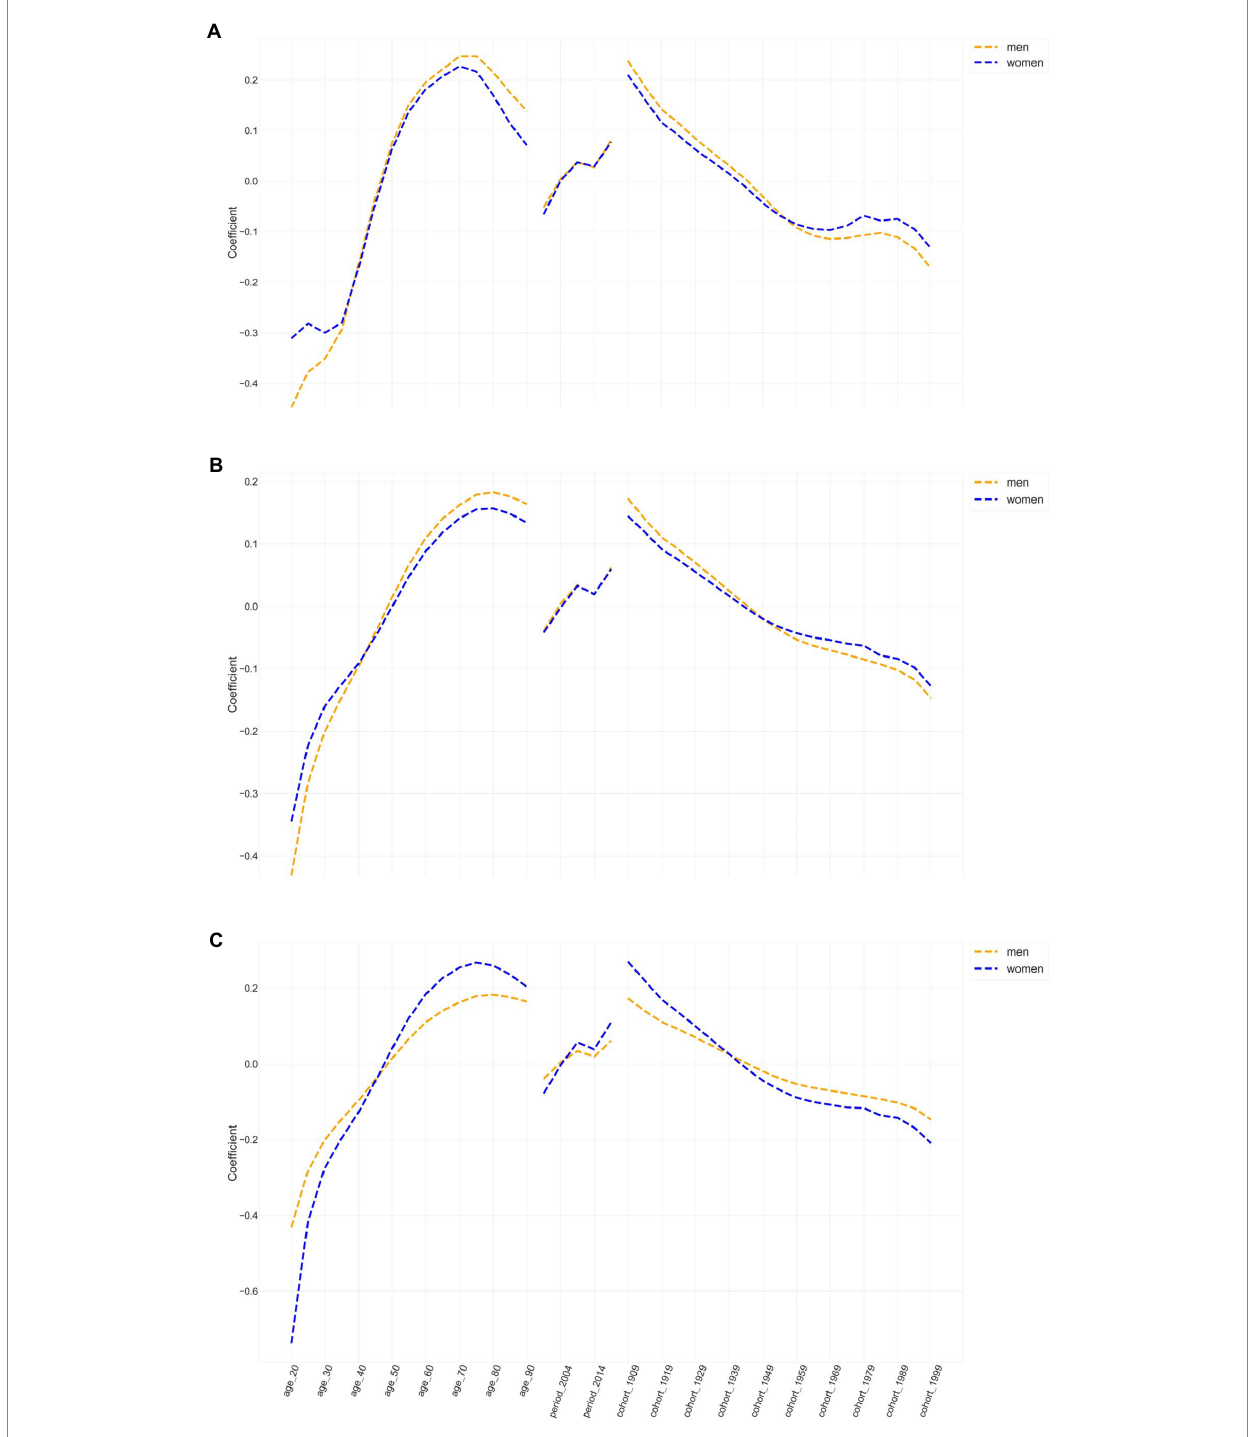
FIGURE 3 The estimated coefficients of age, period, and cohort effects on incidence, prevalence and years lived with disability rates of edentulism in China ( (A) : incidence, (B) : prevalence, (C) : years lived with